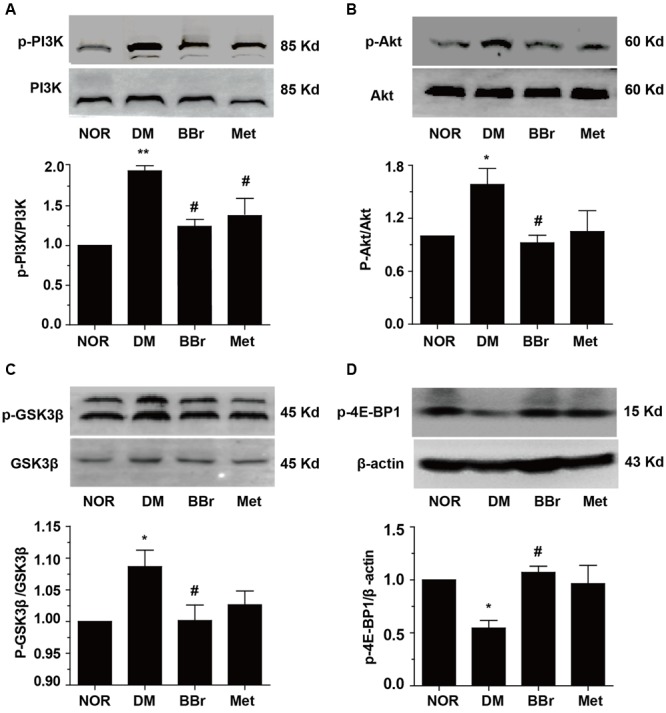
Regulation of PI3K/Akt/mTOR insulin pathway by BBr in the mPFC of DM rats. (A–D) BBr reduced the enhanced expressions of p-PI3K Tyr467
(A), p-AktSer473
(B), p-GSK3βSer9
(C), and p-4E-BP1Thr37/46
(D) in the mPFC of DM, n = 3∼5 for western-blot. ∗P < 0.05 vs. NOR; ∗∗P < 0.01 vs. NOR; #P < 0.05 vs. DM; ##P < 0.01 vs. DM.